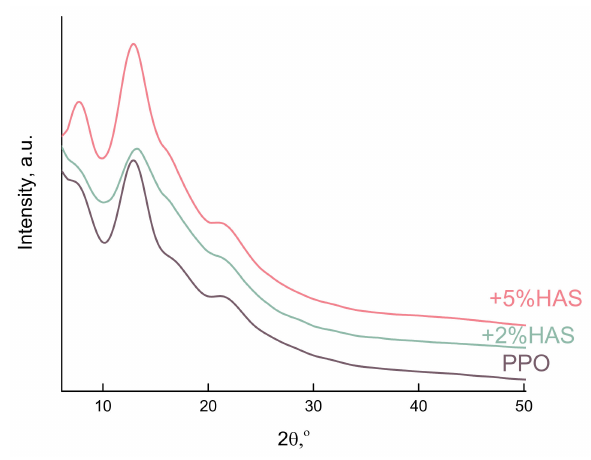
Figure 3. X-ray di ff raction patterns of PPO / heteroarm stars (HAS) (0, 2, 5 wt%) membranes.